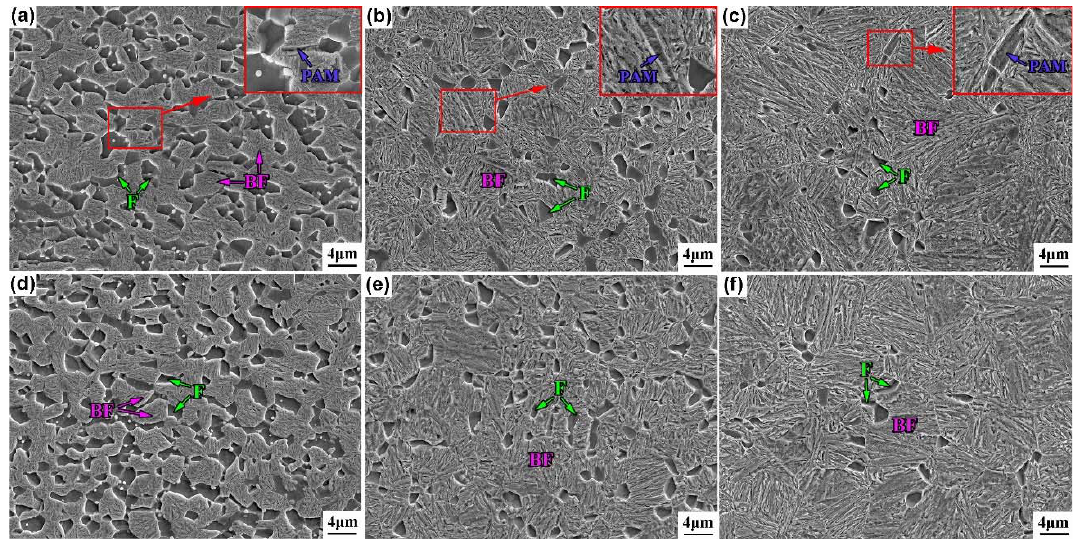
Figure 3. SEM microstructures of the test steel at different heat treatment processes. ( a ): 750–190 ◦ C, ( b ): 760–230 ◦ C, ( c ): 770–250 ◦ C, ( d ): 750–230 ◦ C, ( e ): 760–270 ◦ C, ( f ): 770–290 ◦